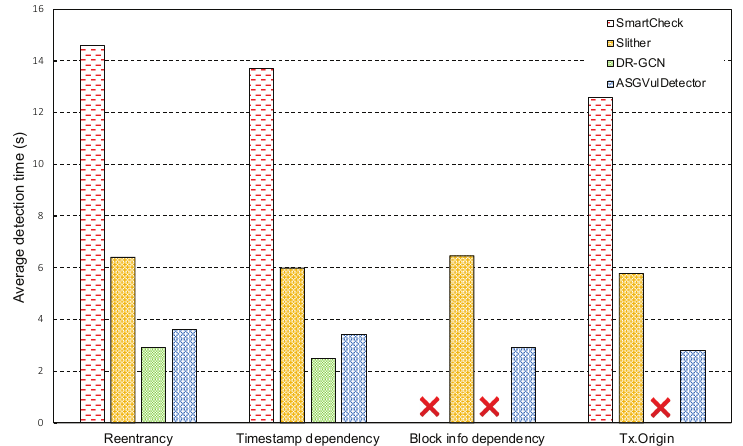
Figure 6. Comparison of detection time for ASGVulDetector